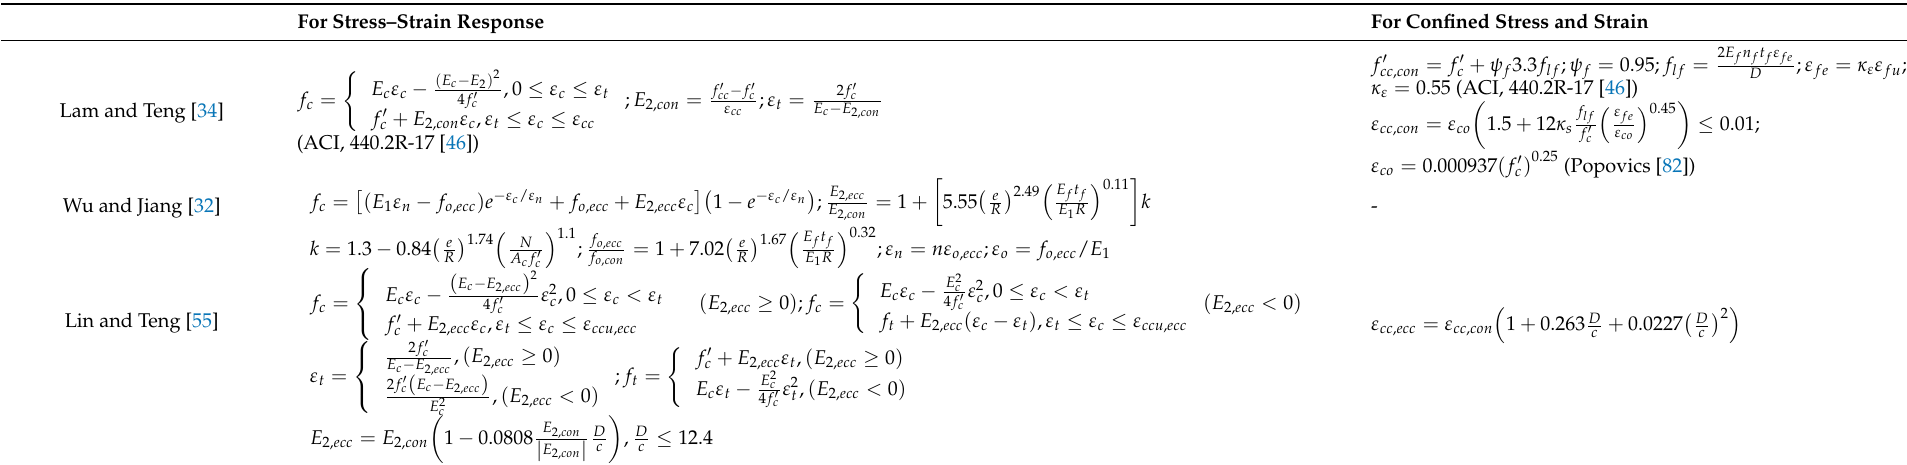
Table A3. Summary of existing stress–strain